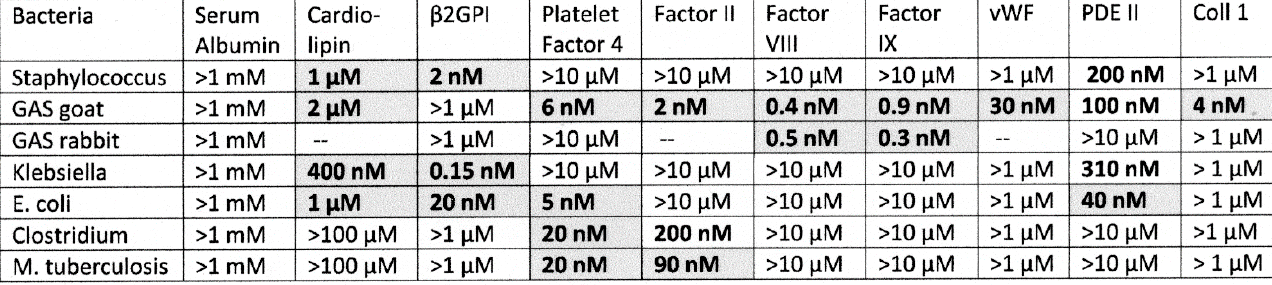
Figure 7. Bacterial antibody binding to cardiolipin..